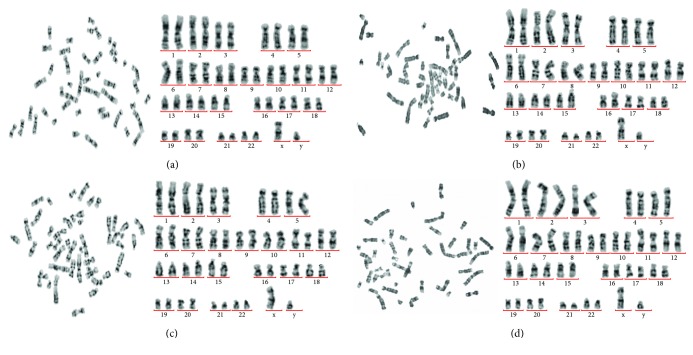
G-banding of metaphase chromosomes. The left panel shows the metaphase spread, and the right panel shows the ordered chromosomal pairs. (a) P5 FBs. (b) P5 tSKPs. (c) P10 FBs. (d) P10 tSKPs.